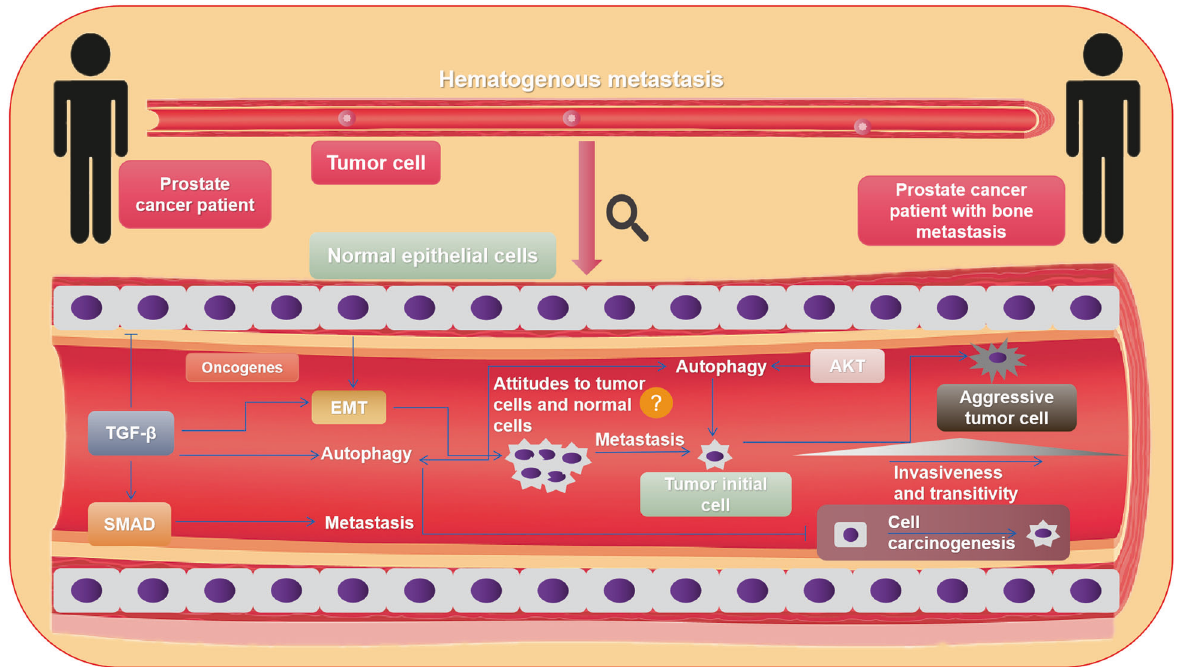
Fig. 3 The mechanism of metastasis via blood in advanced bone metastasis from PC. Bone metastasis from PC mainly occurs via blood, where multiple signaling pathways are involved. Focus on the AKT signaling pathway, which has a remarkable relationship with autophagy, and TGF- β signaling pathway, which can induce EMT formation and release Smad protein to promote tumor